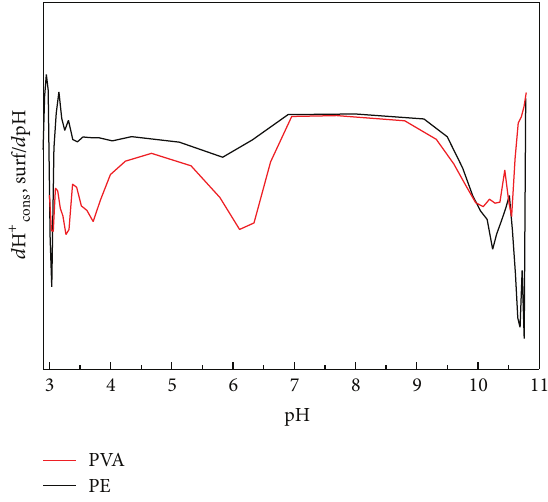
Figure 5: The amount of H + consumed by the surface of biofilms formed on PVA and PE supports. Figure 6: Differential potentiometric titrations curves for the biofilms formed on PVA and PE